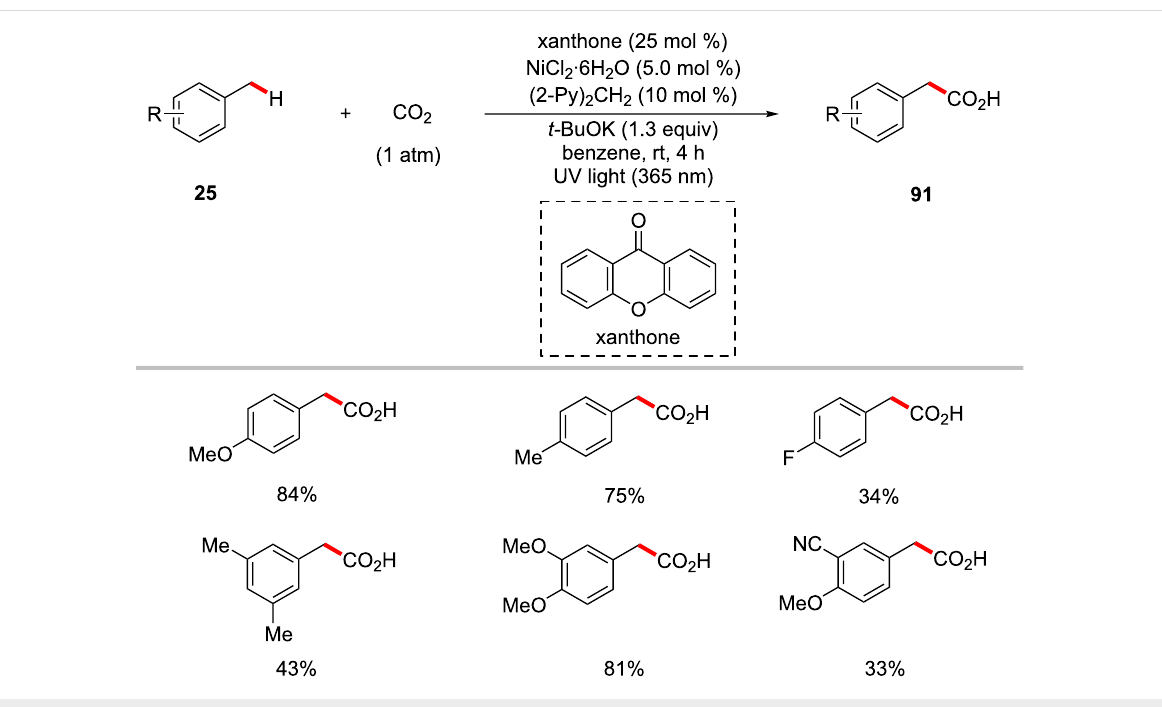
Scheme 47: Photoredox carboxylation of methylbenzenes with CO 2